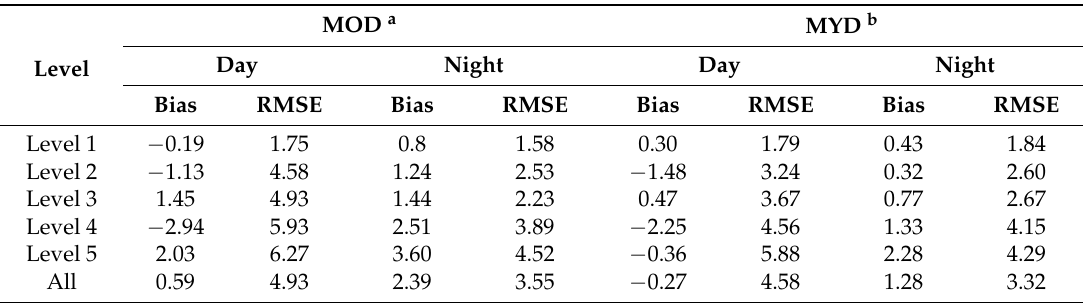
Table 4. Validation results for MOD/MYD11A1 based on the spatial representativeness levels of the station